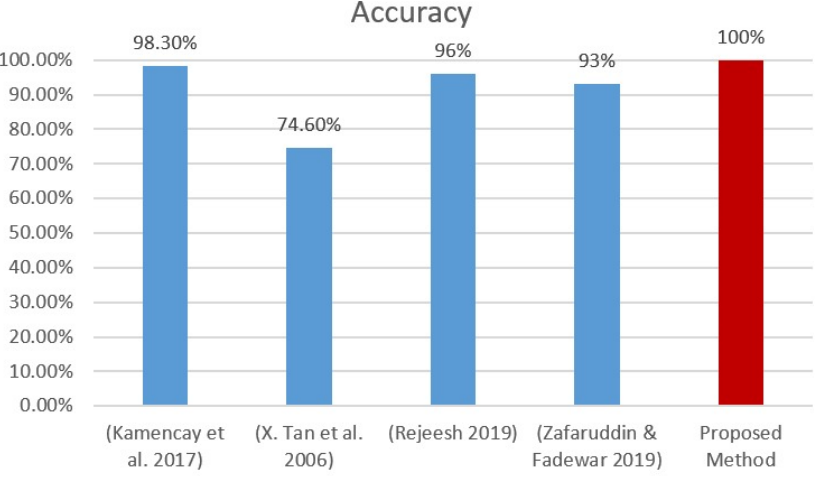
Figure 13. Accuracy analysis for OLR dataset [7,30 – 32].